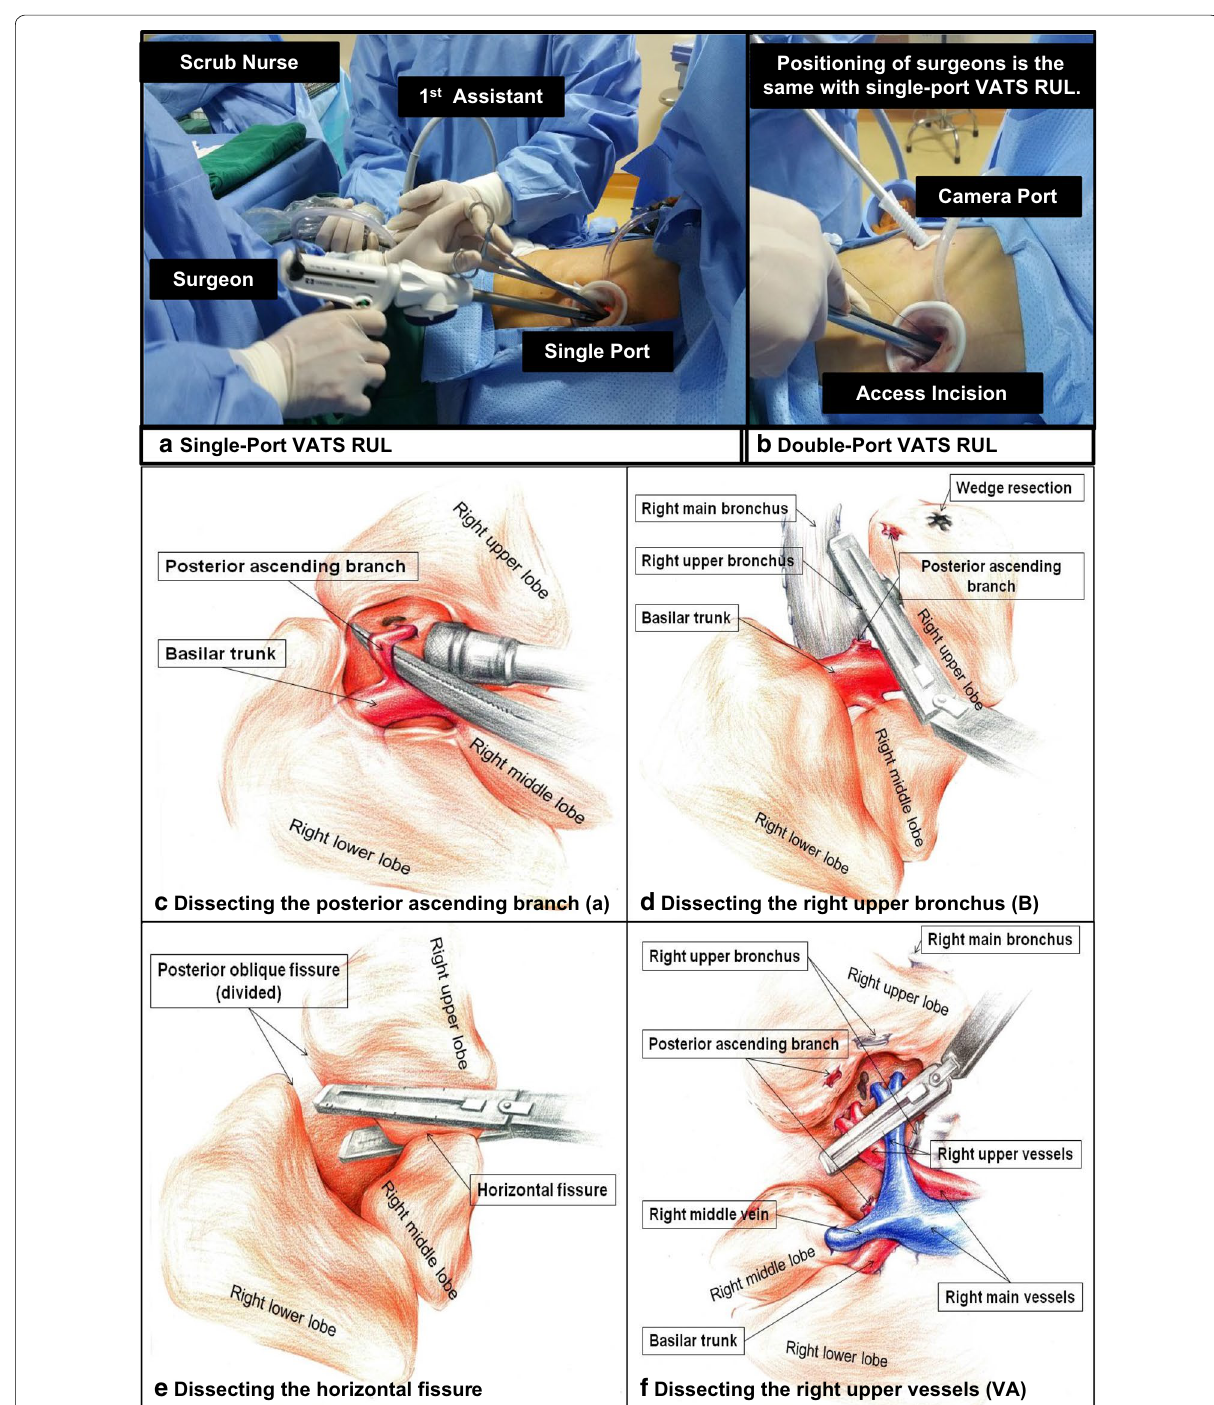
Fig. 1 The positioning of surgical and nursing members during the surgery and four key steps of RUL with the aBVA approach. a The positioning of surgical and nursing members during the single‑port VATS RUL. b The positioning of surgical and nursing members during the double‑port VATS RUL. c Dissecting the posterior ascending arterial branch [a]. d Dissecting the right upper bronchus [B]. e Dissecting the horizontal fissure. f Dissect‑ ing the right upper veins and arteries [VA]. VATS video‑assisted thoracic surgery; RUL right upper lobectomy; aBVA RUL with the dissecting order of the posterior ascending arterial branch [a], followed by the right upper bronchus [B] and pulmonary vessels